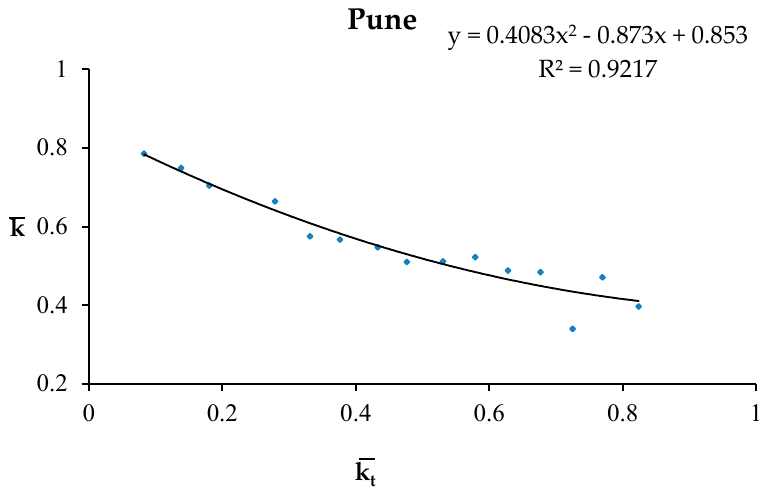
Figure 5. Average values of k vs. k t for Pune.